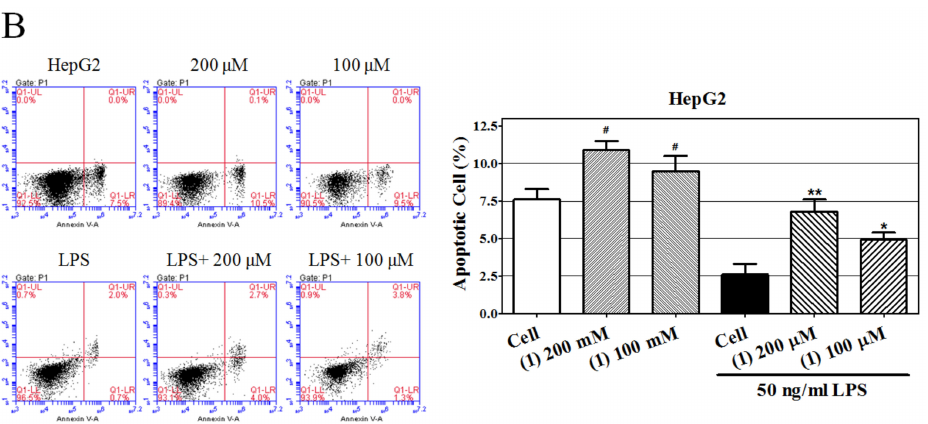
Figure 5. Effect of castanol B (1) on apoptosis of lipopolysaccharide(LPS)-induced hepatomaSMMC-7721 cells of SMMC-7721 cells ( A ) and HepG2 cells ( B ). (# denotes p < 0.05 vs. vehicle-treated hepatoma cells. * denotes p < 0.05; ** denotes p < 0.01; *** denotes p < 0.001, vs. LPS-induced hepatoma cells).